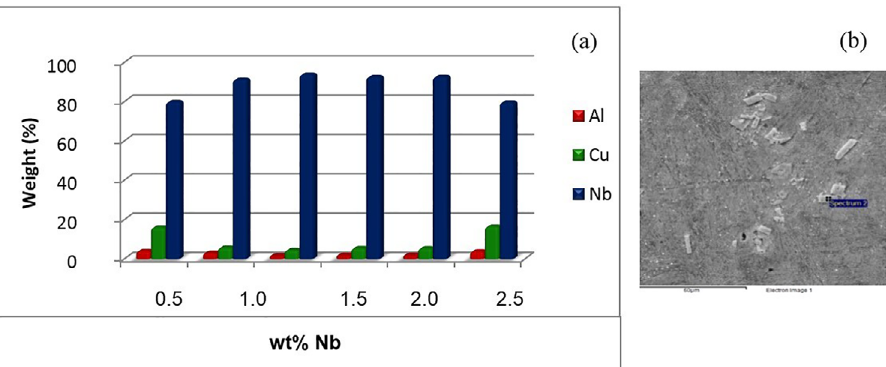
Figure 6. EDS analysis of some particles observed in the matrix of Cu-Al-Nb HTSMA. (a) Graph of chemical composition of the samples by means of point analysis. (b) Nb